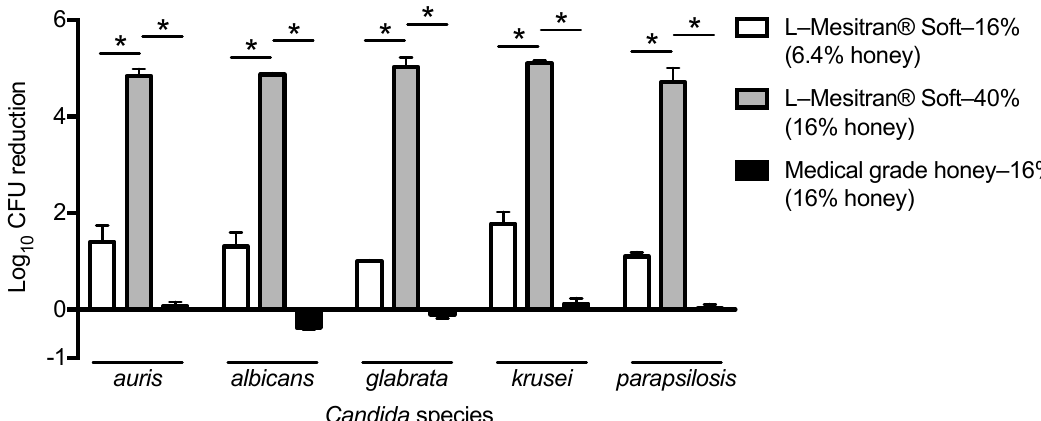
Figure 1. The effect of L-Mesitran ® Soft and its honey component on different Candida species. Isolates from five Candida species ( n = 3 for each species) were incubated with L-Mesitran ® Soft—16% and —40% and medical-grade honey—16%. Data are presented as reduction in CFU. Significant differences ( p < 0.05) are indicated with an asterisk.